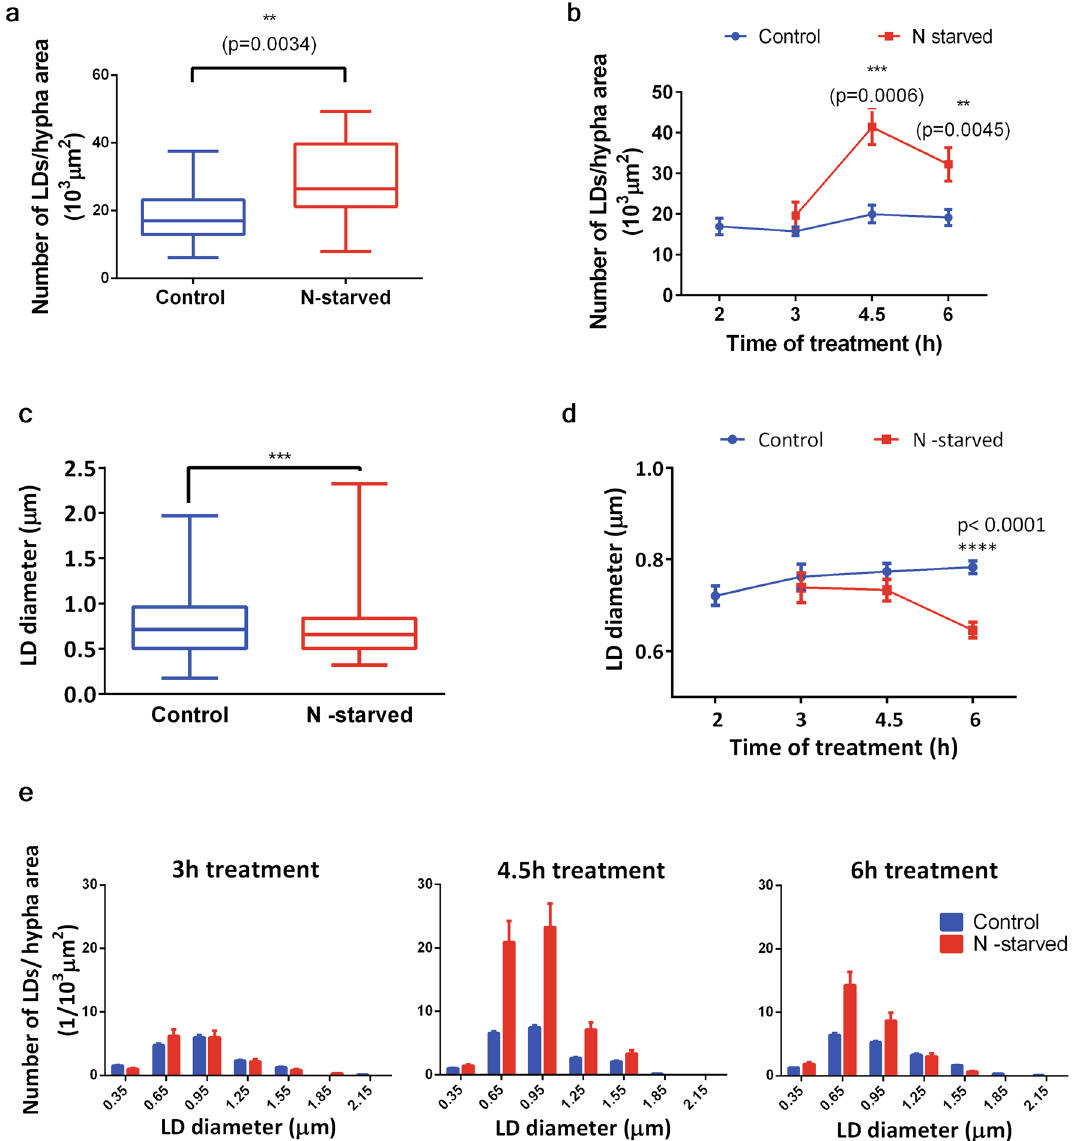
Figure 7. Quantification of LDs from THG images of Phycomyces blaekseneanus hypha. Hypha were cultured without nitrogen or in standard liquid media for 2–6 h (or longer up to 8 h) after the start of treatment. Obtained THG images of LDs were analyzed by PA. n = 6 independent cultures. ( a ) N-starvation increases number of LDs per unit area. LD number obtained from the individual hypha is normalized to hypha area (in 10 3 µm 2 ). Control (n = 44), N-starved group (n = 17). The box and whisker plots, enclosed by the 25th and 75th percentile range, median line with whiskers extending minimal to maximal value. Unpaired t test with Welch’s correction, two tail, p = 0.0038. ( b ) Time course of LD number/unit area, showing that the increase of LD number by N-starvation is significant at 4.5 h ( p = p = 0.0006) and later times ( p = 0.0045), compared to corresponding control. Two-way ANOVA, with Holm-Sidac correction. Mean ± SE, n (Control) = 8; 7; 11; 21 for time points (in h), respectively: 2; 3; 4.5; 6. n (N-starved) = 6; 3; 7 for time points (in h), respectively: 3; 4.5; 6. ( c ) N-starvation decreases diameter of LDs. LD diameters from Control (n = 1205) and N-starved group (n = 431). The box and whisker plots, enclosed by the 25th and 75th percentile range, median line with whiskers extending minimal to maximal value. Mann–Whitney ( p = 0.0008), two-tailed. ( d ) Time course of LD diameter changes, showing that the decrease by N-starvation is significant only at long starvation times. Two-way ANOVA, Holm- Sidac correction ( p < 0.0001), compared to corresponding control. Mean ± SE, n (Control) = 176; 124; 302; 571 for time points (in h), respectively: 2; 3; 4.5; 6. n (N-starved) = 100; 118; 214 for time points (in h), respectively:3; 4.5; 6. ( e ) Differential distribution of increased number of LDs after 4.5 h and 6 h N-starvation. The largest LDs are lost at longest starvation times. Histograms of LD diameter distributions, 0.3 µm binning, for Control and N-starved group. Number of LDs in each bin of the histogram is divided by sum of hypha area of the appropriate group. Errors are calculated as stated in Methods section. Numbers on x axes represent the upper bin